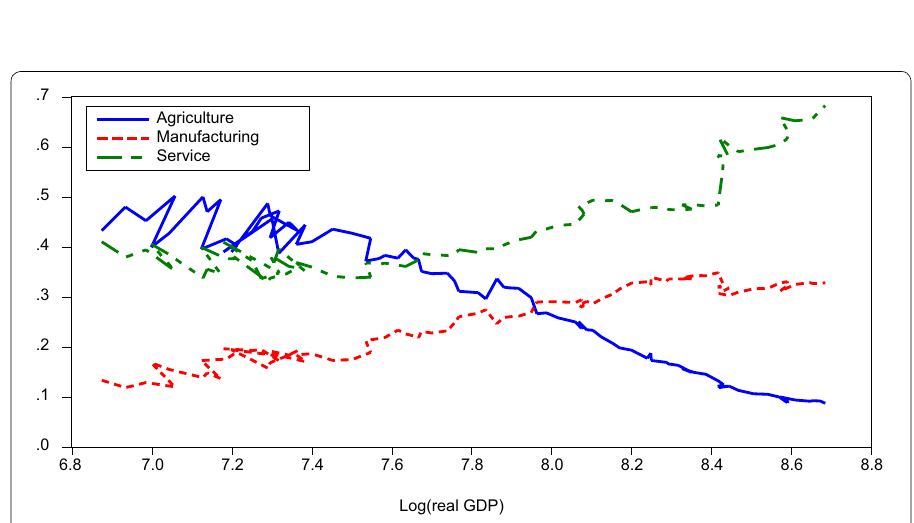
Fig. 8 Sectoral shares of production in the three sectors, and GDP in Turkey (annually, 1923–2014). Source: Author’s calculation. Production is real value in each sector, derived from the Ministry of Development’s report (Economic and Social Indicators between 1950 and 2014). For additional information see Fig.